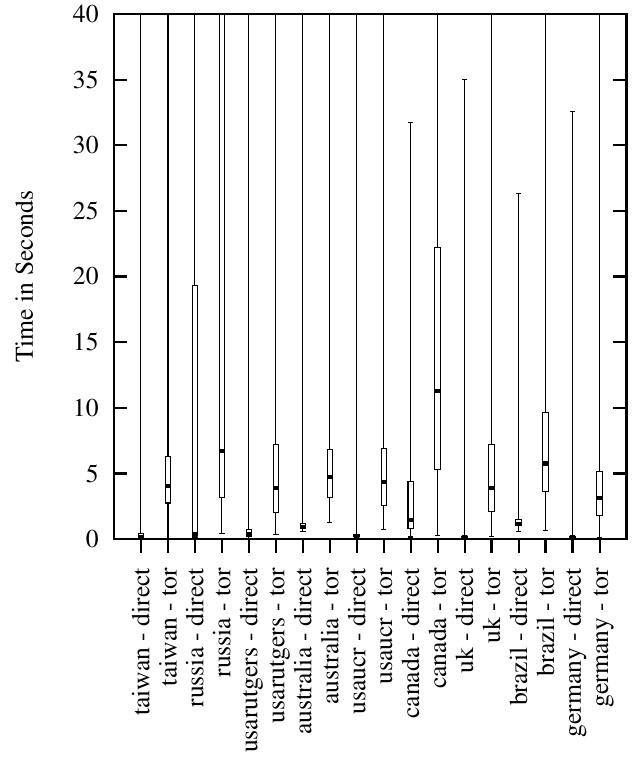
Figure 5. Average Download Throughput (Time for 50 KB).